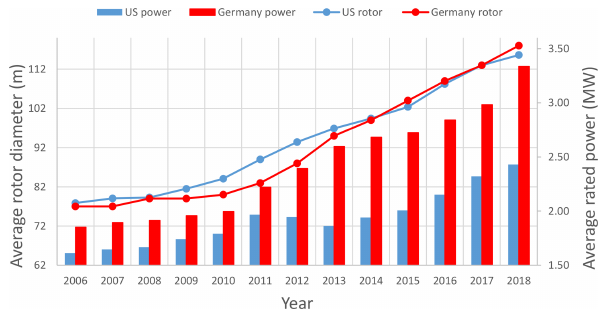
Figure 2. Average rotor diameters and rated powers for wind tur- bines in Germany and the US from 2006 to 2018. Data sources: Fraunhofer (2018) and US Department of Energy